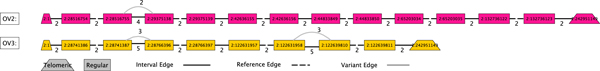
Tandem duplications on Chr2 in OV2 and OV3. Tandem duplications found on Chr2 in OV2 and OV3. OV2 has a single site of tandem duplication, while OV3 has two sites of tandem duplication. Note that the region duplicated in OV2 is much larger than the region duplicated on OV3, and the duplicated region in OV2 contains several cancer associated genes including PLB1, PPP1CB, ALK [39-41].